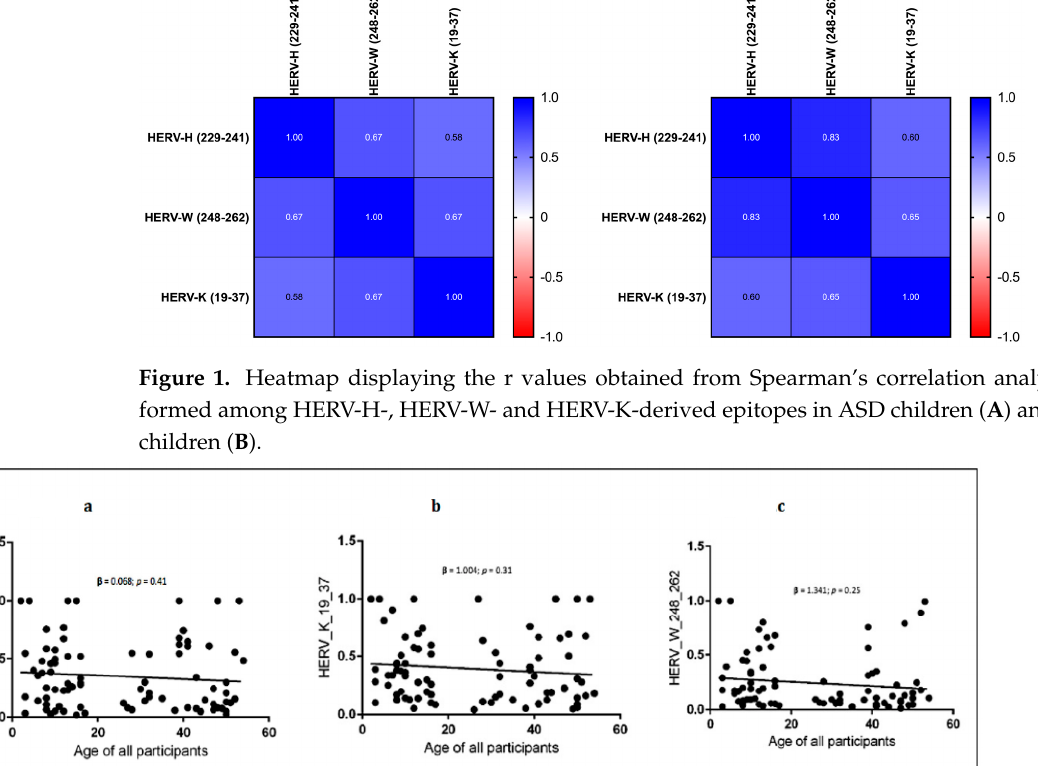
Figure 2. Linear regression between HERVs antibody levels and age of all participants (children and mothers). ( a ) shows the linear regression between anti-HERV-H and age; ( b ) shows the linear regression between anti-HERV-K and age; ( c ) shows the linear regression between anti-HERV-W and age.95% CI, confidence interval fixed at 95%. Statistical significant levels fixed at * p < 0.05. Table 6. Linear regression between all the ages and HERV levels.